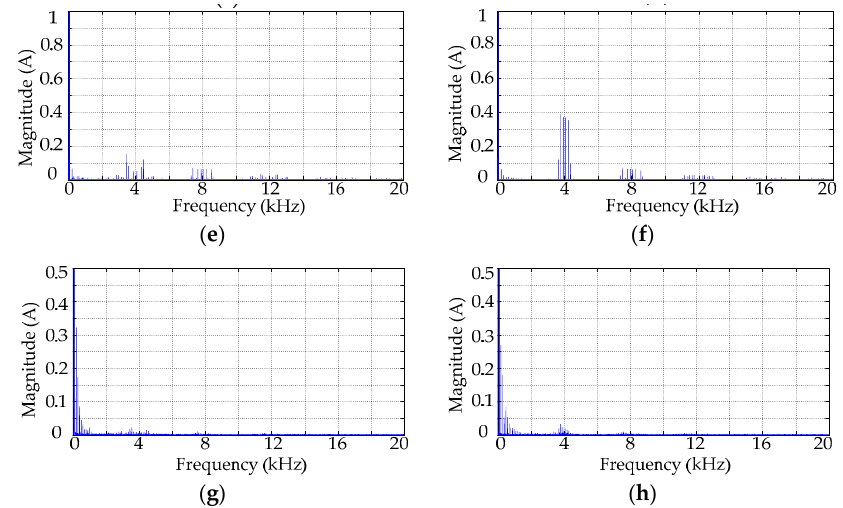
Figure 12. Harmonic spectra of experimental waveforms for the DCPDPWM and PSCPWM methods with circulating current harmonics cancellation scheme: ( a ) phase voltage of DCPDPWM; ( b ) phase voltage of PSCPWM; ( c ) line-to-line voltage of DCPDPWM; ( d ) line-to-line voltage of PSCPWM; ( e ) phase current of DCPDPWM; ( f ) phase current of PSCPWM; ( g ) circulating current of PDPWM; and ( h ) circulating current of PSCPWM.